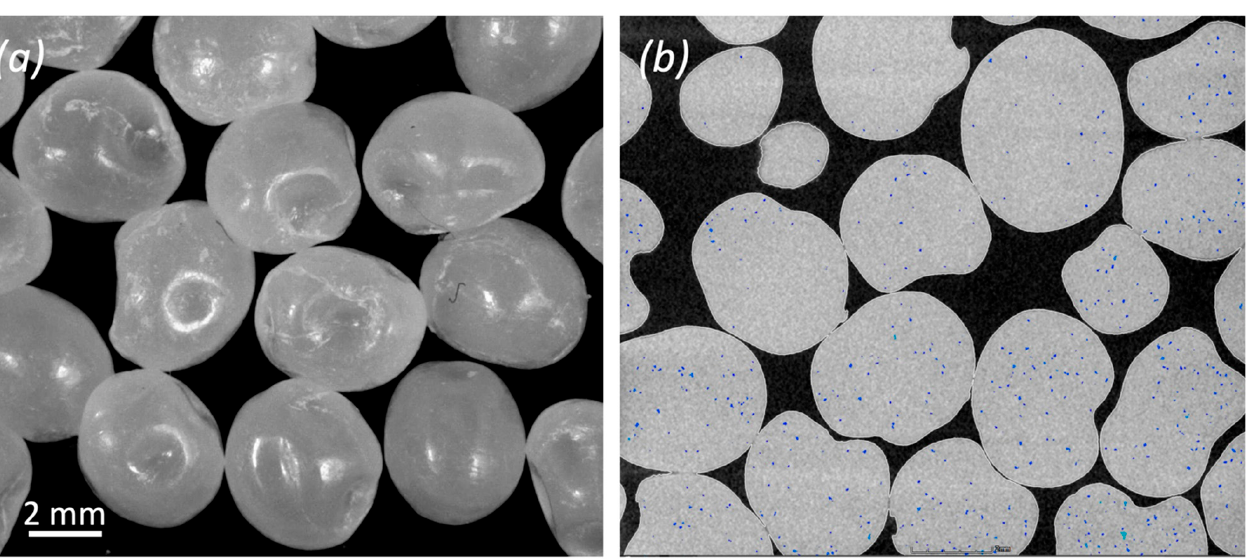
Figure 1. Morphology of the PLA feedstock: ( a ) Optical microscopy image of PLA pellets; ( b ) X-CT two-dimensional image of the internal structure of PLA pellets. The blue points represent internal microporosities of volume lower than 0.001 mm 3 .